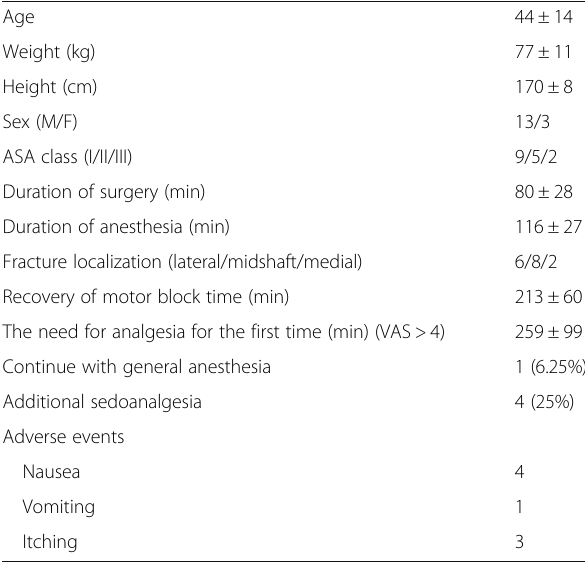
Table 1 The demographic and operational characteristics of the patients and adverse